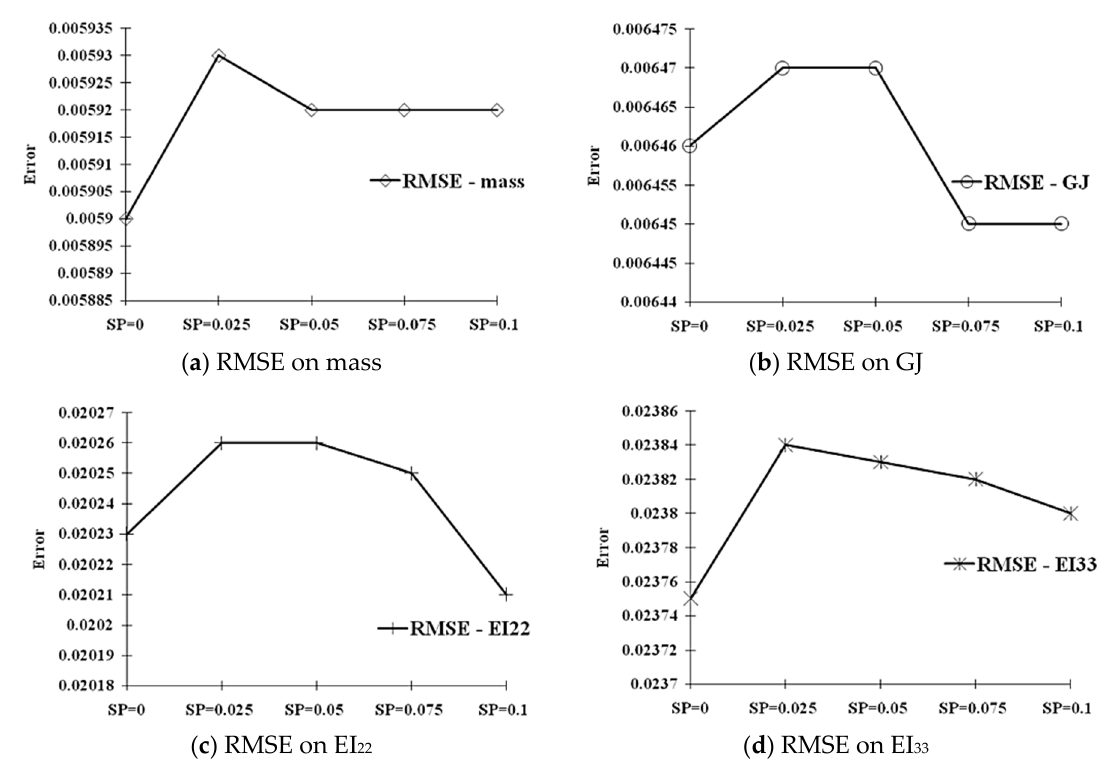
Figure 13. RMSE according to variation of SPP.